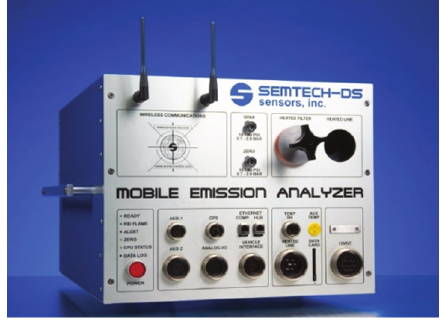
Fig. 5. The SEMTECH DS. exhaust emission